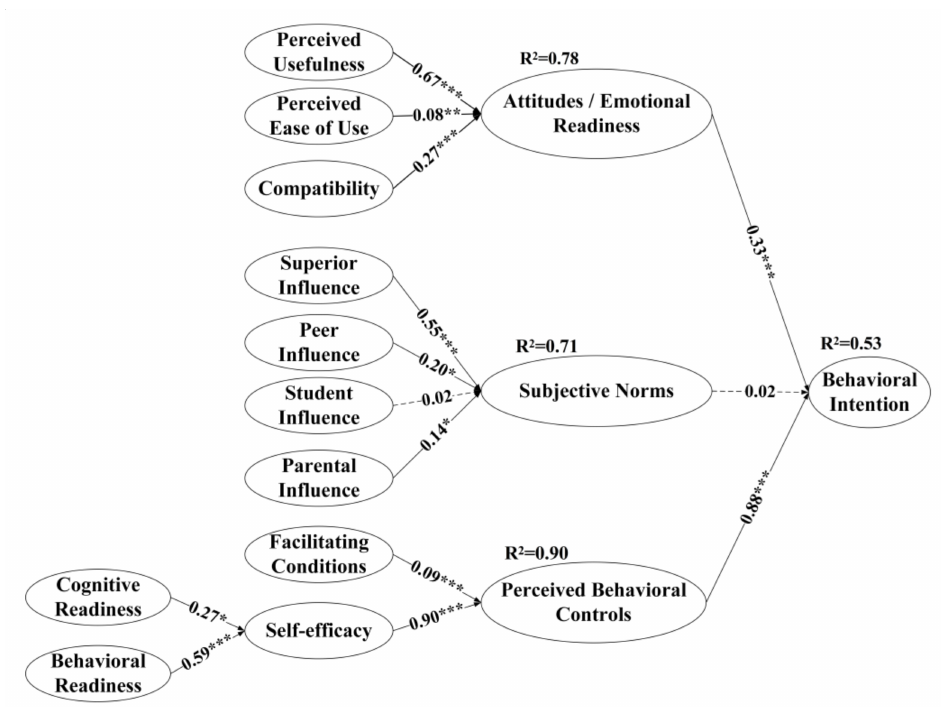
Figure 2. Final model with the coefficients ( β ) and p -values. Note. Dotted lines indicate an insignifi- cant relationship; * p < 0.05, ** p < 0.01, and *** p <